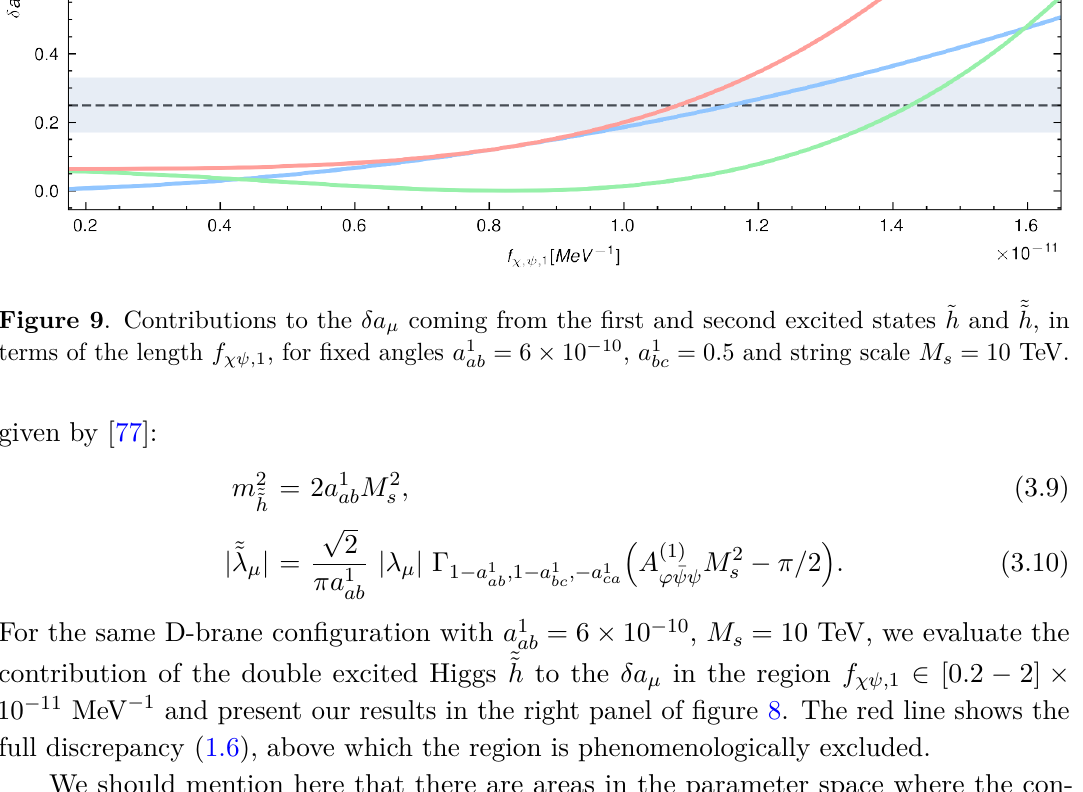
= 6 10 − 10 , a 1 = 0 . 5 and string scale M s = 10 TeV ab bc ×